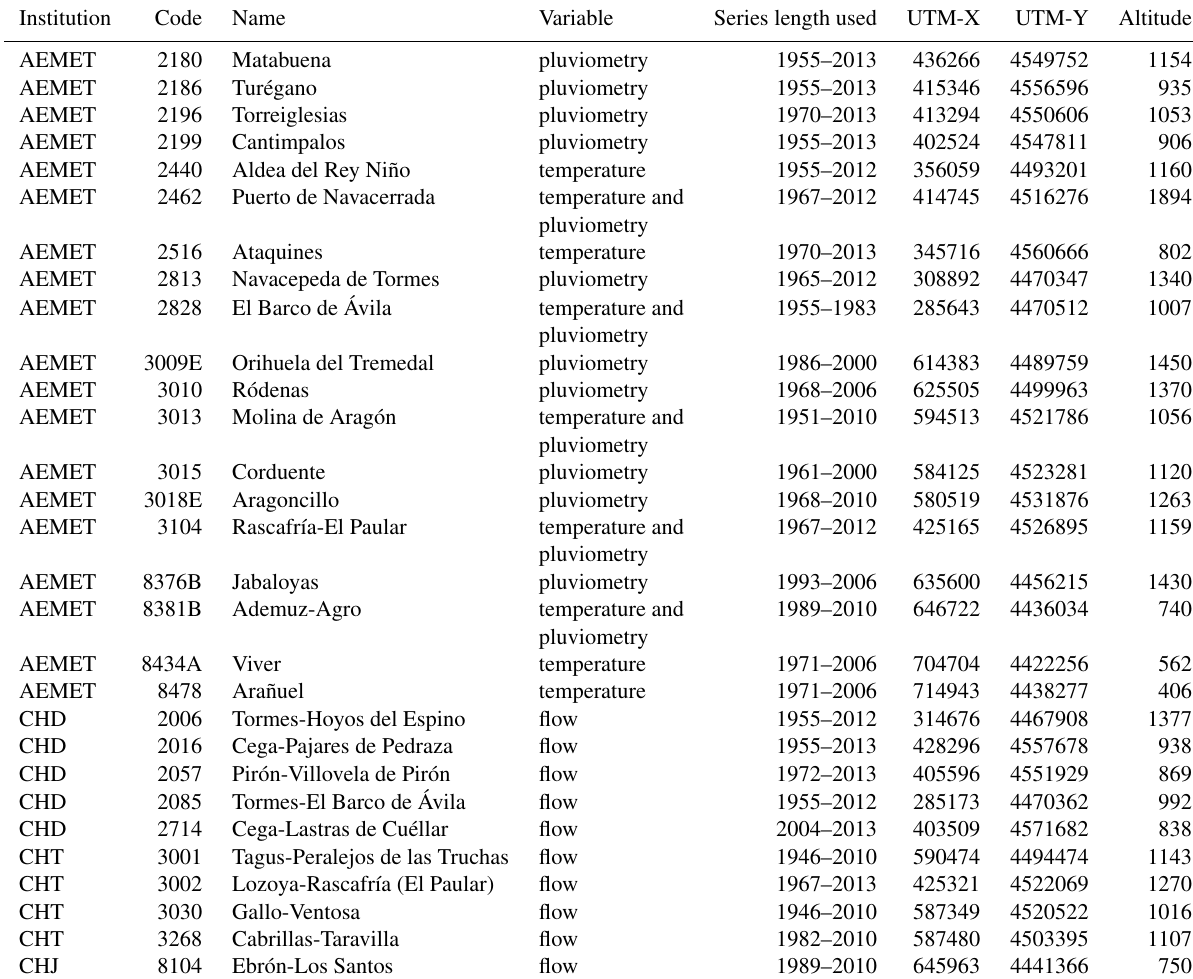
Table 2. Official stations used (meteorological and hydrological), variables, length of time series used and geographical position. AEMET: Spanish Meteorological Agency; CHD: Water Administration of Duero Basin; CHT: Water Administration of Tagus Basin; and CHJ: Water Administration of Júcar